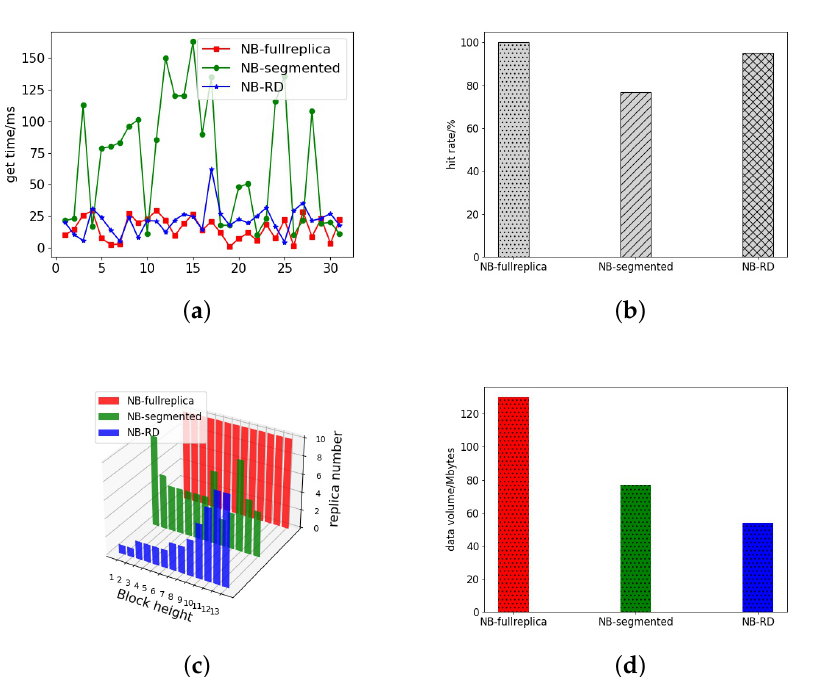
Figure 15. Simulation time = 10,000 s. ( a ) Data acquisition time. ( b ) Access hit rate. ( c ) Block replica number. ( d ) Replica data amount.